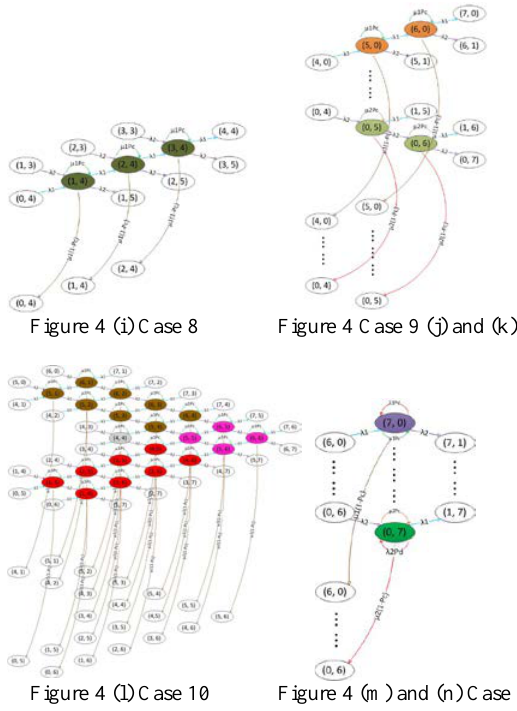
Figure 4 (f)~4 (n): System state transformed from busy mode to transmit mode